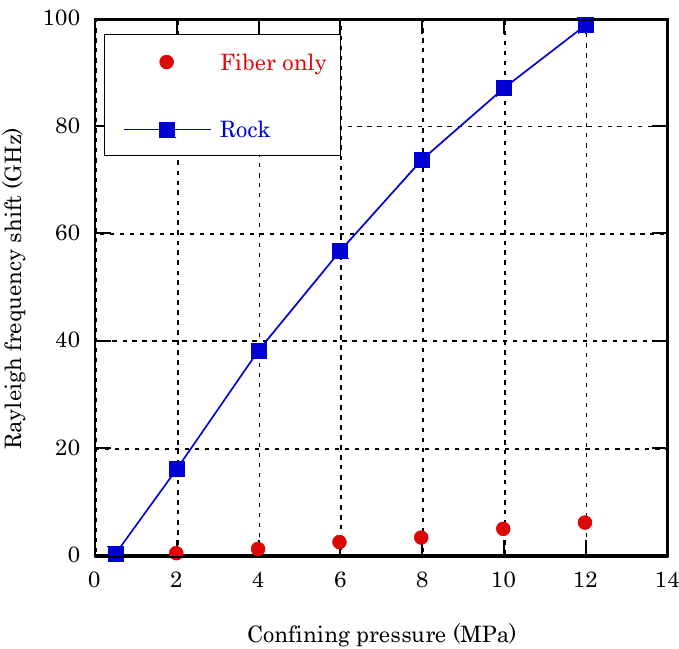
Figure 6. The mean value of Rayleigh frequency shift measurements at the 11 censoring points with increasing confining pressure, in comparison with the baseline value (sensor region B), for Berea core.